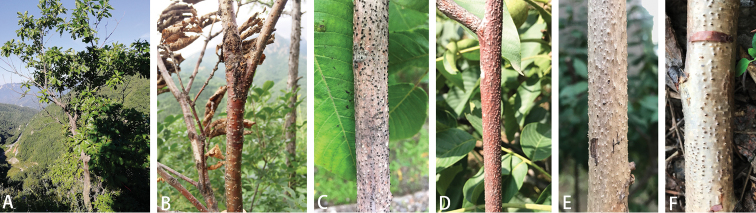
Disease symptoms associated with diaporthalean species. A, BQuercus
mongolicaCJuglans
regiaD, EJuglans
mandshuricaFBetula
dahurica.